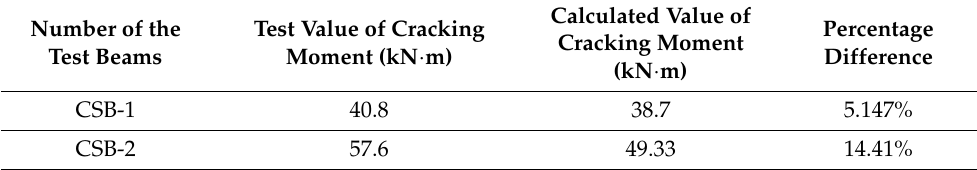
Table 3. Comparison of the cracking